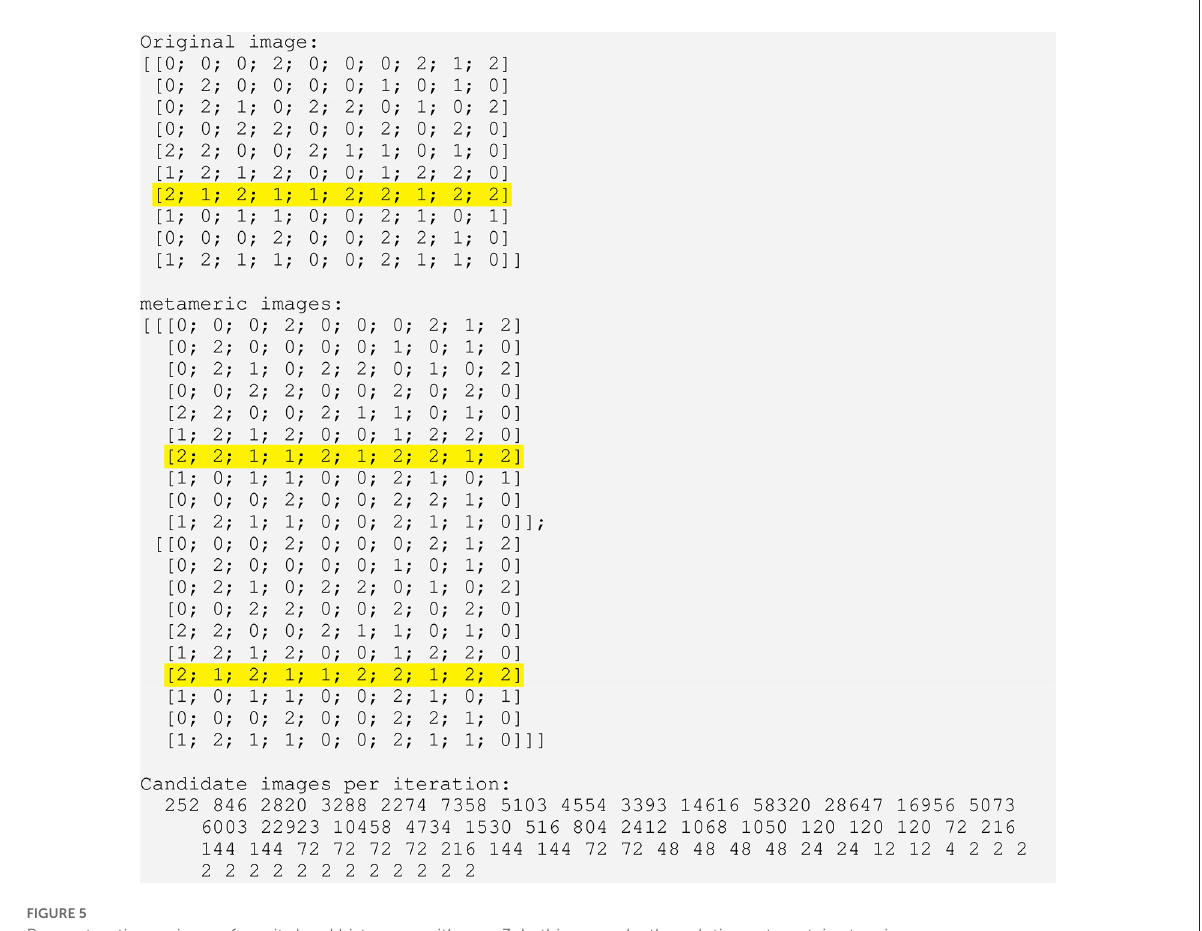
FIGURE5 Reconstructing an image from its local histogram with m = 3. In this example, the solution set contains two